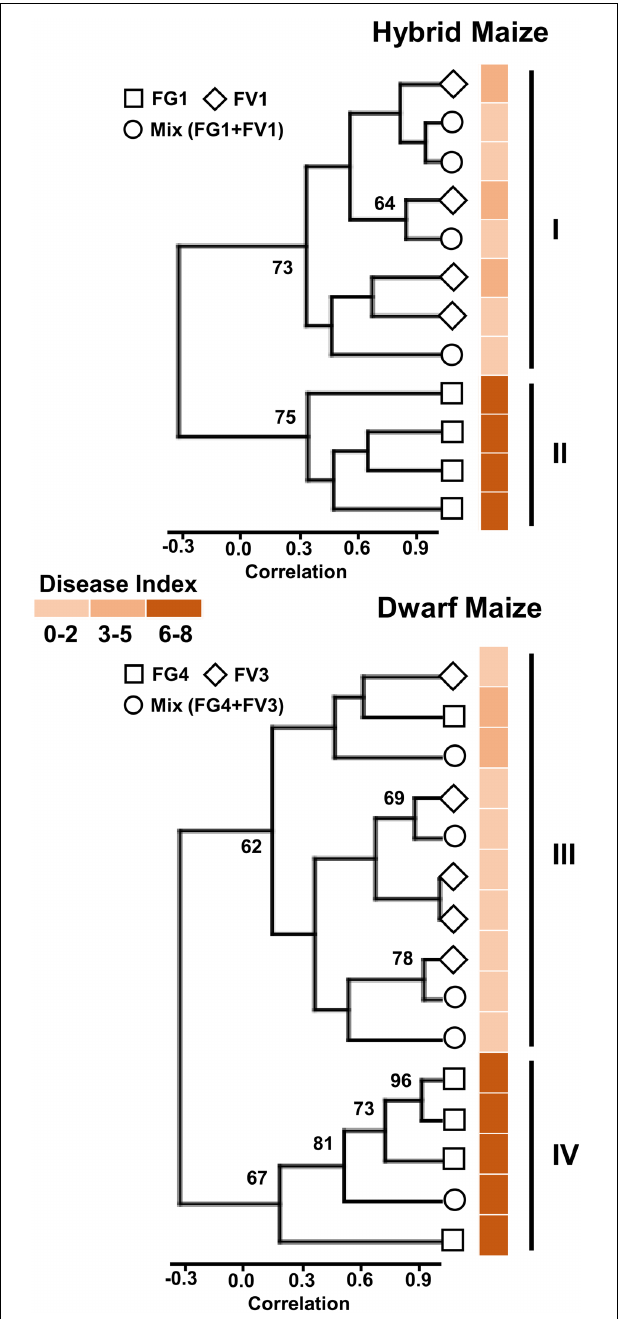
FIGURE 2 | Cluster tree based on volatile infection biomarkers of maize ears infected with one or two Fusarium species. Bootstrap values > 60% are indicated ( N = 10,000 bootstraps) on the tree along with disease index (color coded) for each individual samples (maize ears).